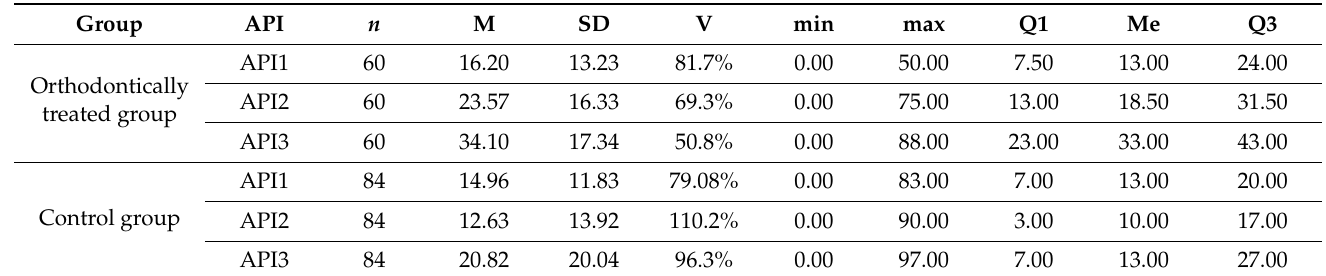
Table 1. Mean values of the Approximal Plaque Index (API) in both groups.